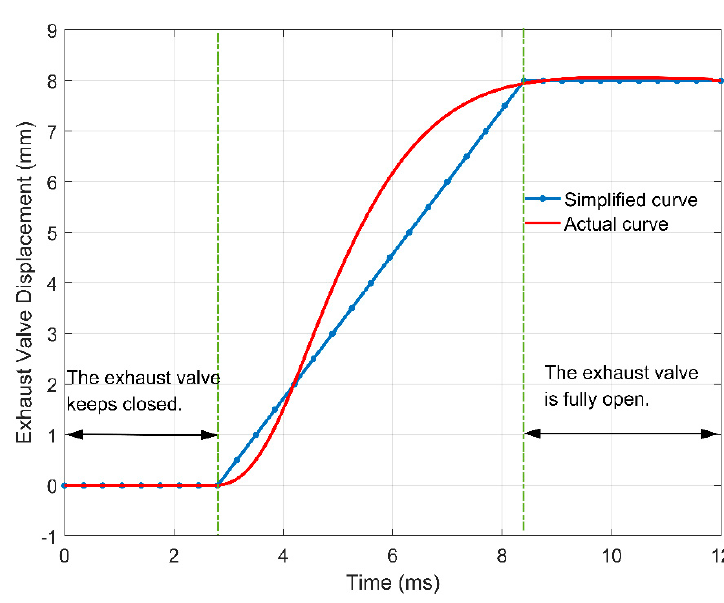
Figure 6. Four-stroke operation mode of the engine.